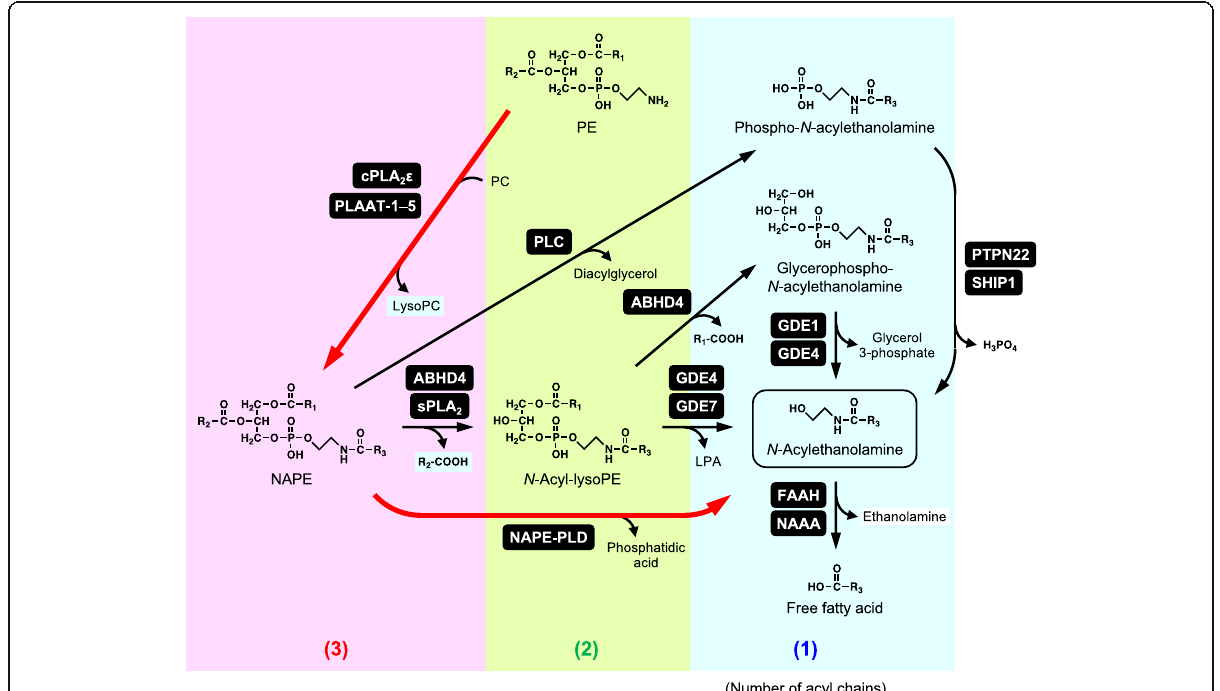
Fig. 3 Metabolism of N -acylethanolamines. Red thick arrows represent the canonical pathway. H 2 O is omitted in the hydrolytic reactions. Numbers of acyl chains per molecule are indicated in parentheses. cPLA 2 cytosolic phospholipase A 2 , PLC phospholipase C, sPLA 2 secretory phospholipase A